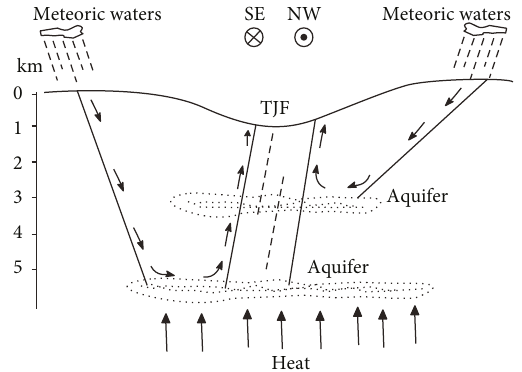
Figure 9: Simpli fi ed conceptual model of fault control mechanism of the